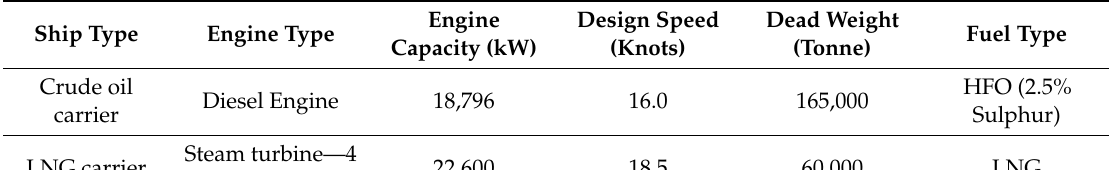
Table 3. Specifications of crude oil carrier and liquefied natural gas (LNG) carrier in the Well-to-Tank stage [20].